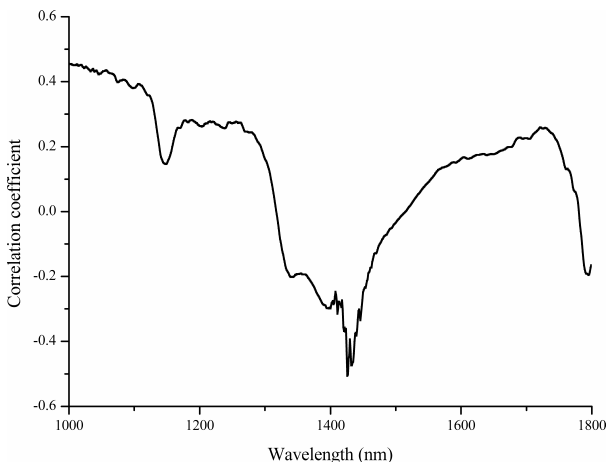
Fig. 6. Relational graph of LV numbers and SECV of seco- loganic